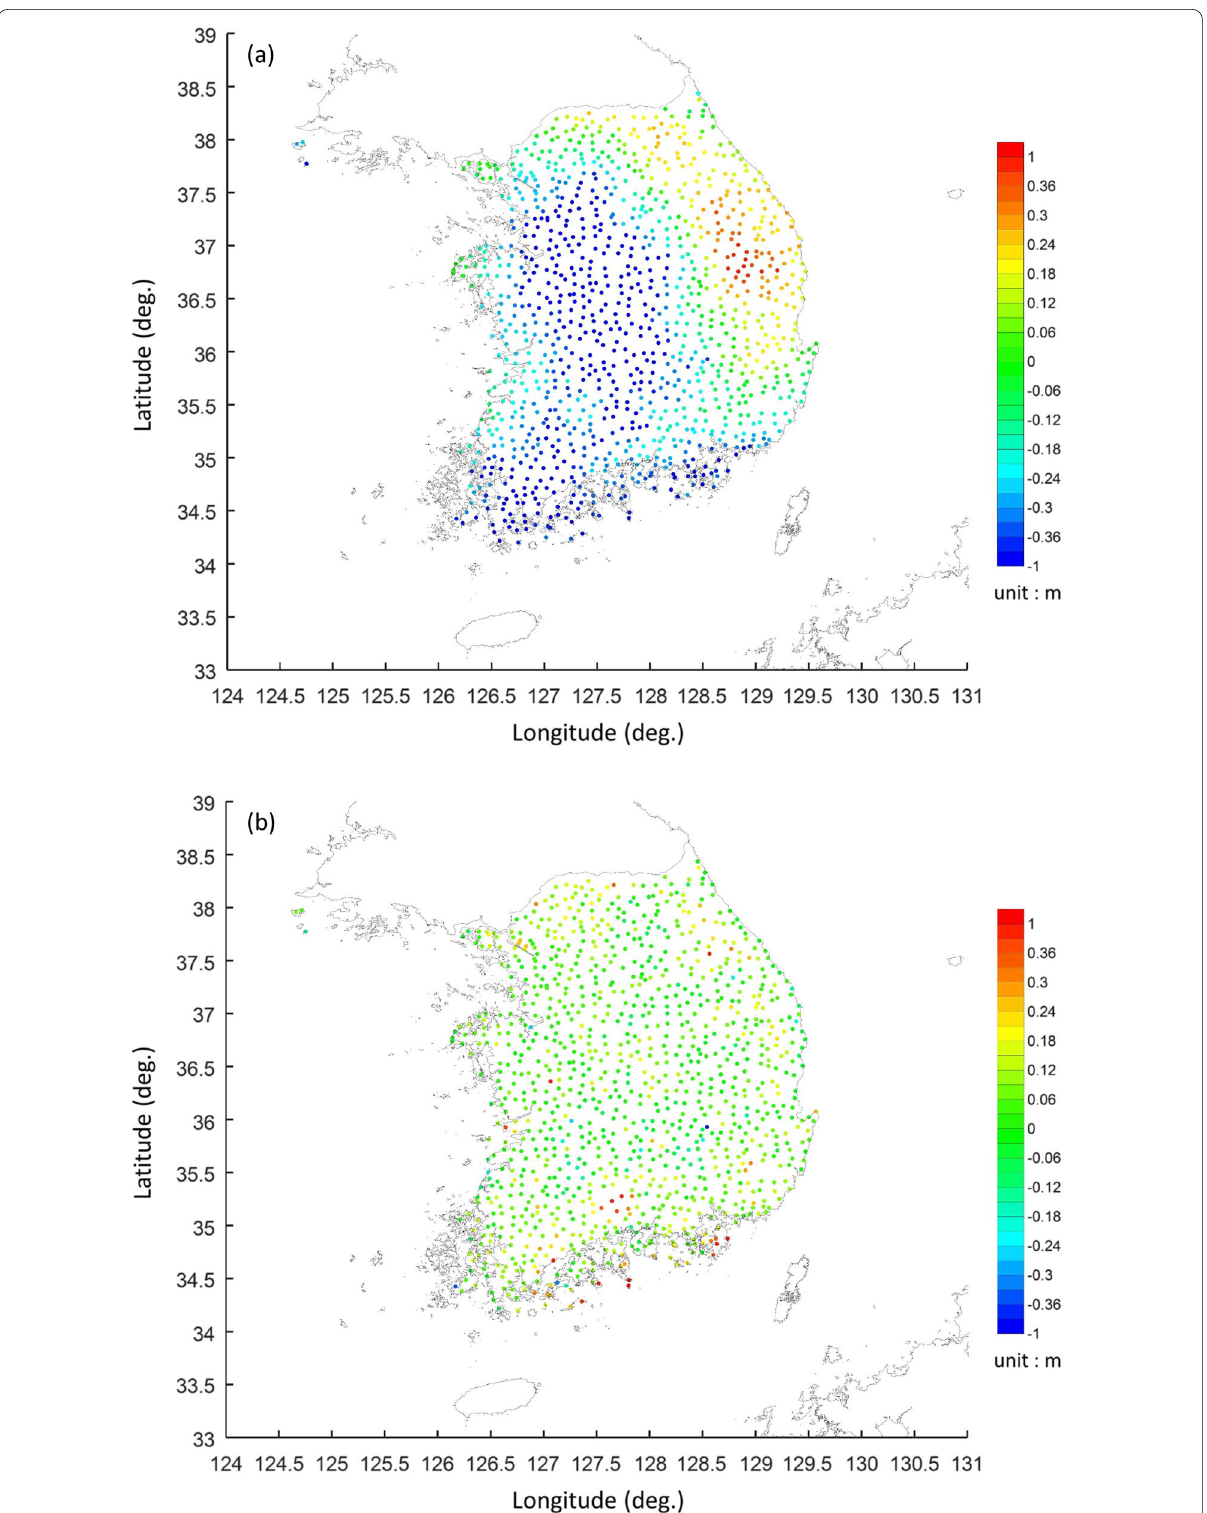
Fig. 2 Geoidal height difference between a NORI05 and b GMK09 GNSS/Leveling data obtained by the NGII [re-plotted referring to the products of Kwon et al.